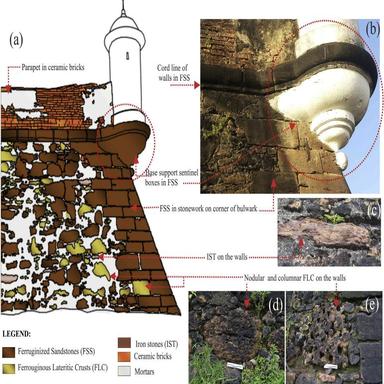
Several other FSS applications in FSJM: (a) drawbridge console; (b) staircase steps; (c, d) examples of FSS stonework blocks in corners where the characteristic color and cross-stratification are very evident.